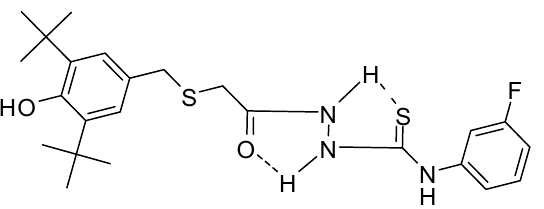
Figure 3. Intramolecular hydrogen bonding of thioxo form of 1-acylthiosemicarbazide 3 .